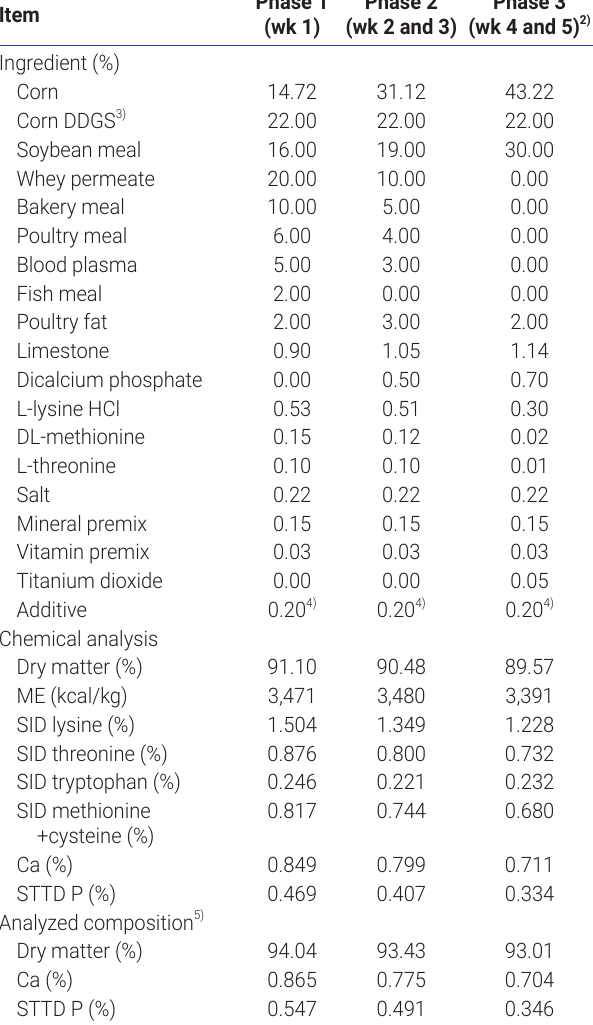
Table 2. Feed ingredients and calculated composition of experimen- tal diets in a 3-phase feeding program fed to newly-weaned pigs